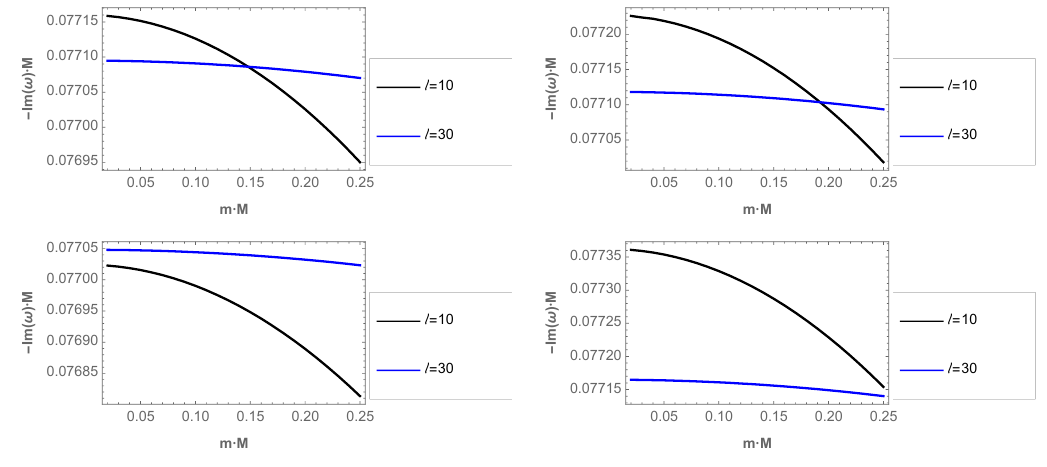
Figure 10 . Top panel for the behaviour of − Im ( ω ) M of the photon sphere modes, left panels for the mode n PS = 0 , and right panels for the mode n PS = 1 , as a function of mM for ‘ = 10 , 30 , with Λ M 2 = 0 . 04 , qQ = 0 . 01 (top panels), and qQ = 0 . 05 (bottom panel). Here, the WKB method gives via eq. (3.18) µ c M ≈ 0 . 175 , for qQ = 0 . 01 , and µ c M ≈ 0 . 176 , for qQ = 0 . 05 .